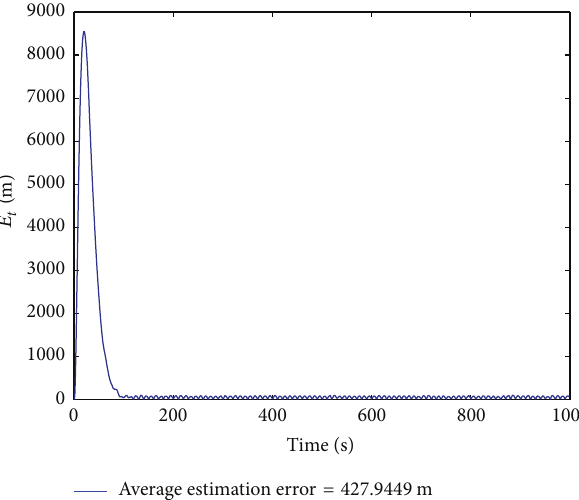
Figure 21: Estimation error of 𝛼 - 𝛽 - 𝛾 filter with 𝑔 𝑟,1 = 𝑔 𝑝,1 = 𝑔 2 = 0.1 .